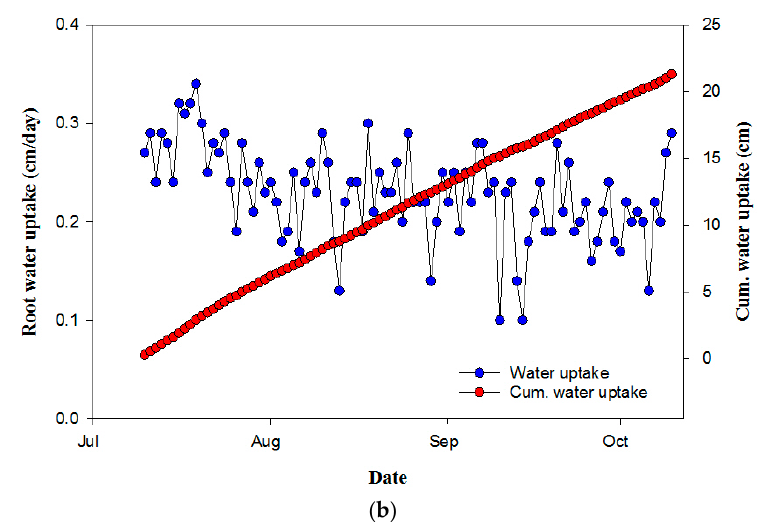
Figure 6. Simulated actual daily root water uptake and simulated cumulative water uptake during the ( a ) off-season and ( b ) main season.